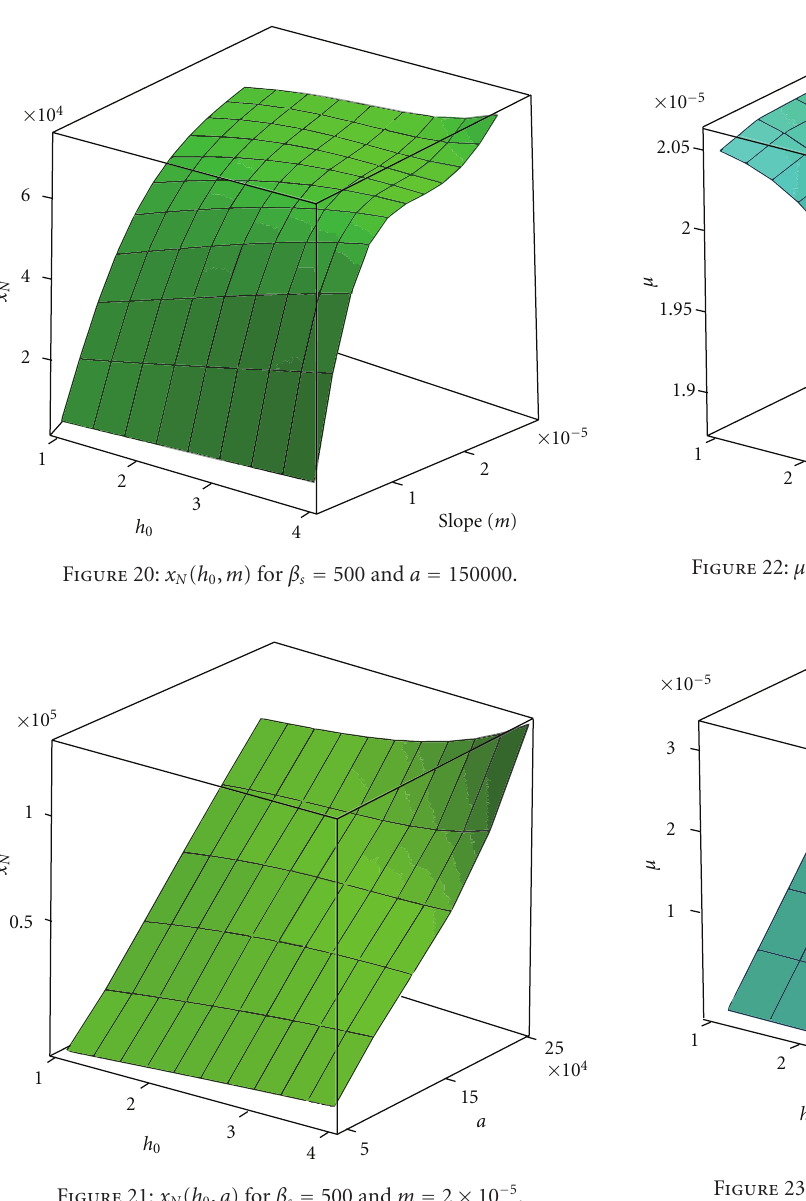
Figure 21: x N ( h 0 , a ) for β s = 500 and m = 2 × 10 − 5 .